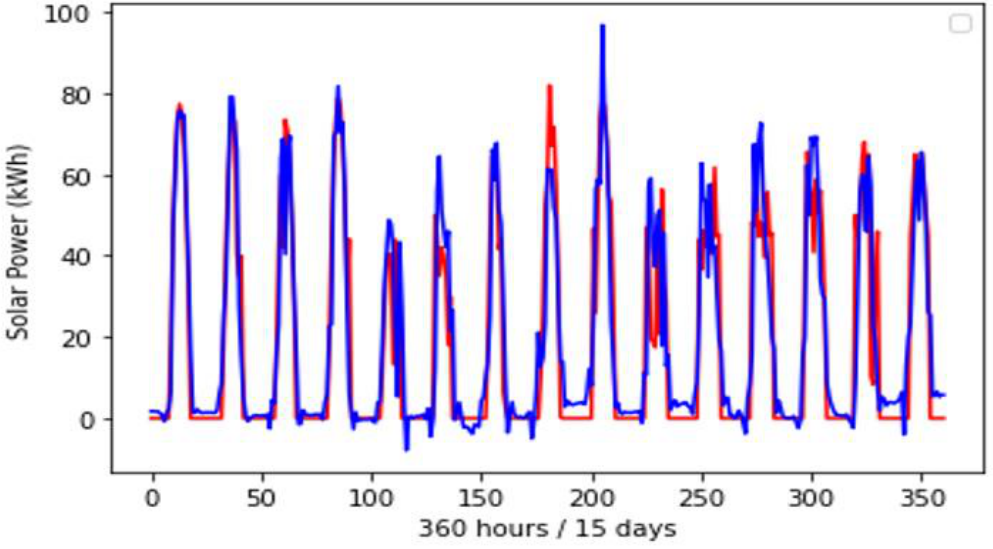
Figure 18. Performance of the Stacked LSTM model for predicting 15 days-ahead solar power generation(red line = actual value, blue line = predicted value).